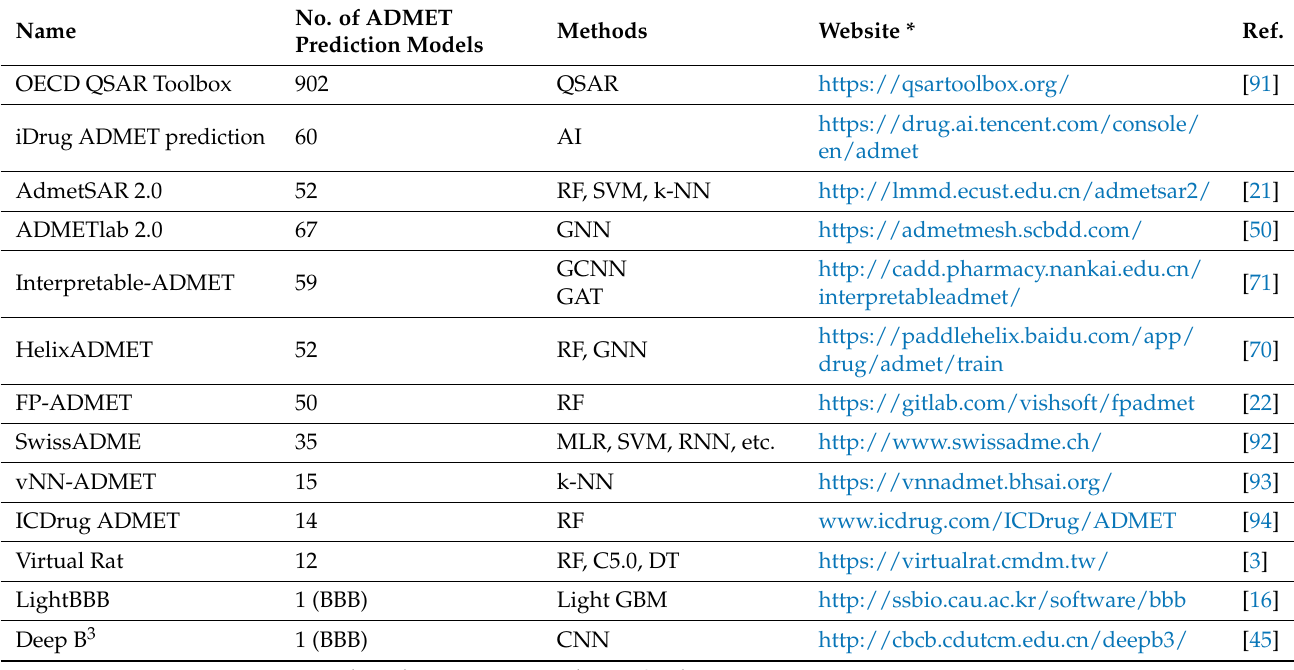
Table 5. Public AI-based ADMET prediction